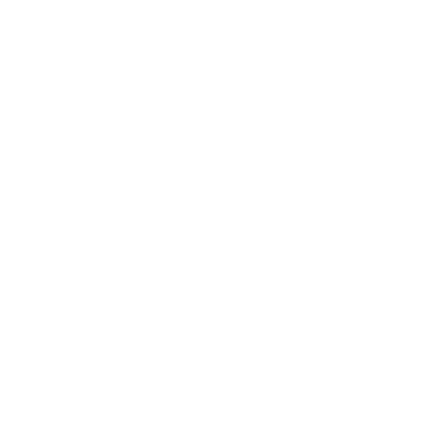
Figure 15. The proximity values recorded for the liver during the movement of the robot in four tests.